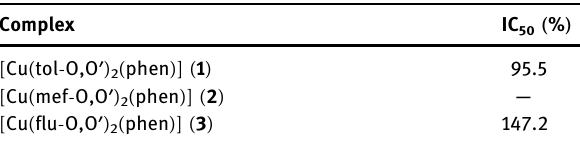
Table 3: Inhibitory concentrations of complexes 1 – 3 required to cause a 50% decrease in the growth of S. cerevisiae ( IC 50 ) esti - mated after a 24 h period Complex IC 50 ( % ) [ Cu ( tol - O,O ′ ) ( phen )] ( 1 2